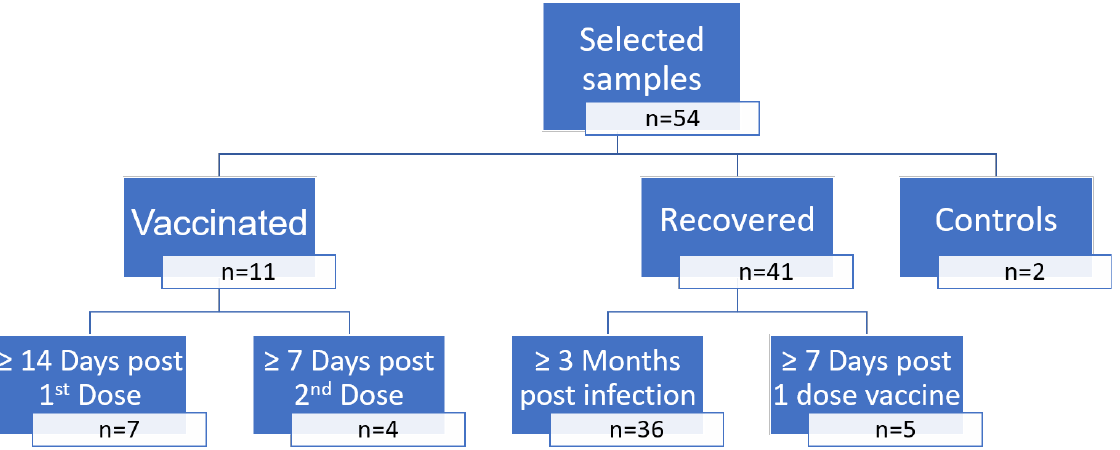
Figure 1. Samples selected to determine thresholds of anti-S eCLIA and sVNT values predictive of neutralizing activity using a cVNT as a gold standard.